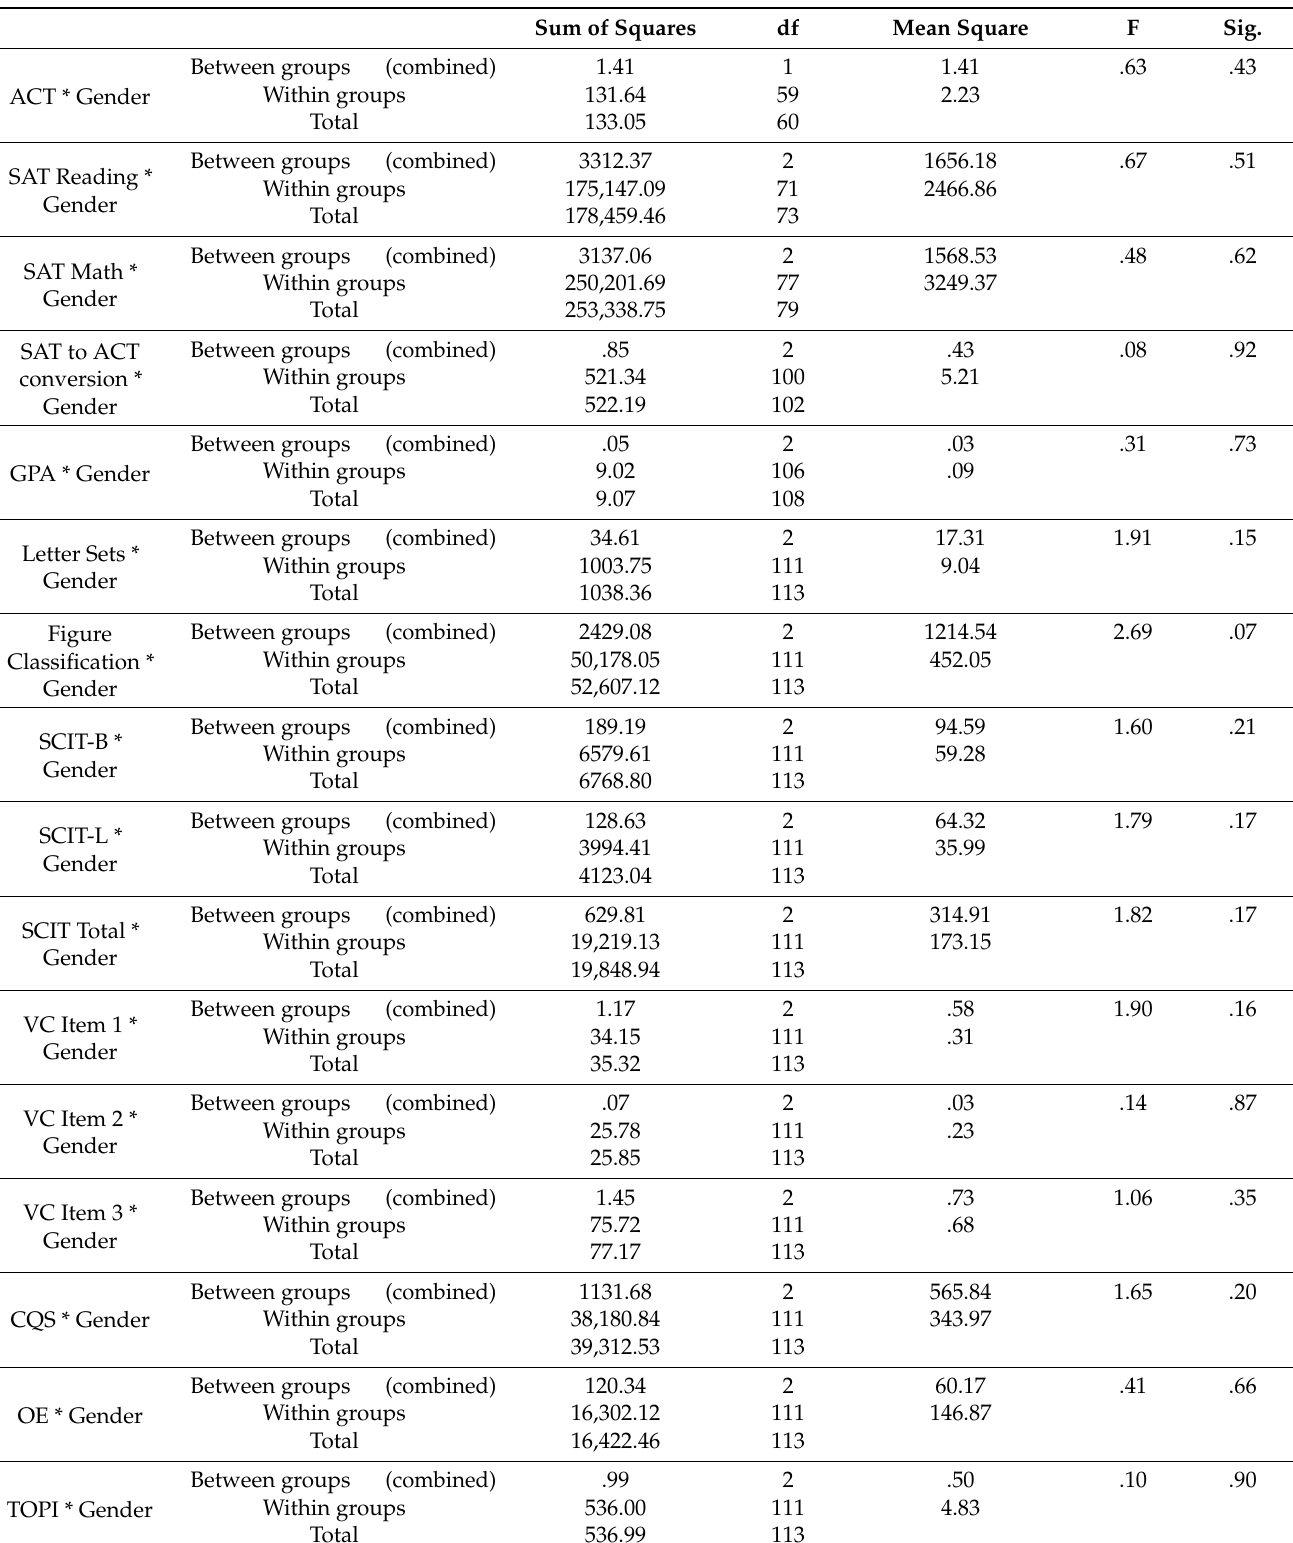
Table 2. Gender-based Analysis of Variance. Sum of Squares df Mean Square F